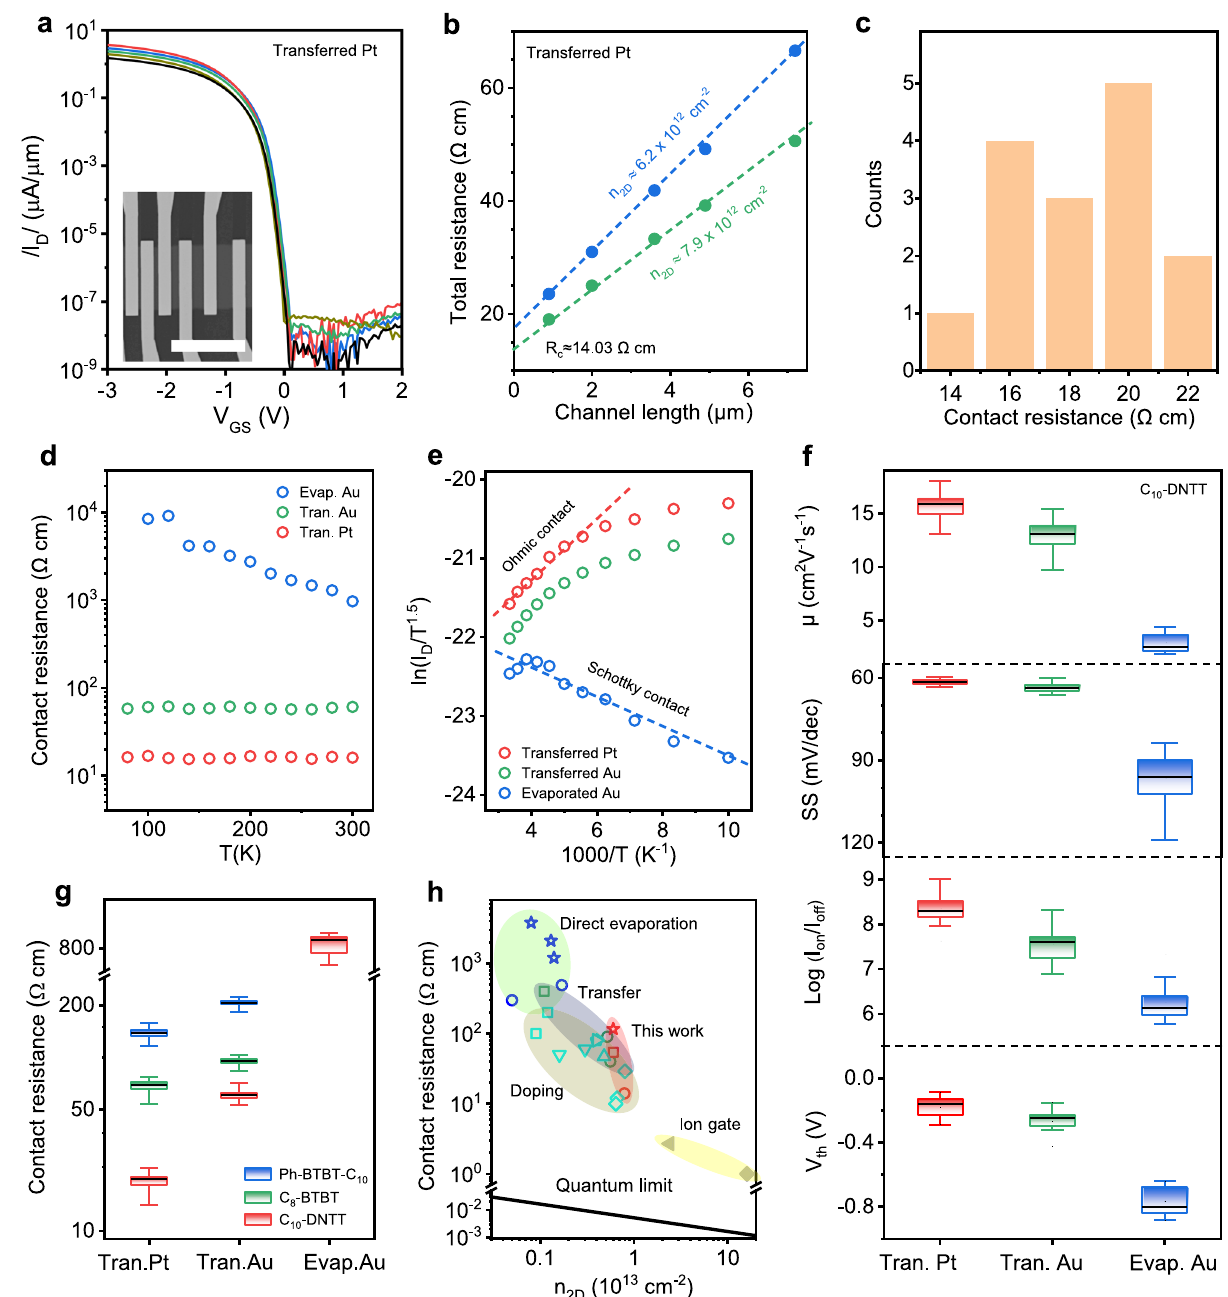
Fig. 2 | Electrical contact properties of transferred-Pt, transferred-Au, and evaporated-Au monolayer C 10 -DNTT OTFTs. a Room temperature I D ~V GS char- acteristics of a typical TLM structure of transferred-Pt OTFTs with a channel length of 0.9, 2.0, 3.6, 4.6, and 7.2 μ m under V DS = − 1.0V. The TLM structure has the same channel width of 27 μ m. Inset shows the scanning electron microscope (SEM) image of TLM structure. Scale bar, 30 μ m. b R c extraction using TLM methodfromthedevicein a . c Histogramofthecontactresistanceoftransferred- Pt OTFTs. d The R c as a function of temperature in three types of OFETs. The contact resistances in c , d were extracted at V DS = − 1.0V and n 2 D =7.9×10 12 cm − 2 . e ArrheniusplotsoftheOhmictransferred-Pt(redopencircle)andtransferred-Au (green open circle) OTFTs at V GS = − 3.0V and V DS = − 0.3 V, and Schottky evapo- rated OFETs (blue open circle) at V GS = − 3.0V and V DS = − 1.0V, respectively. The channellengthandwidthseeSupplementary Figs. 5and7. f Statistics ofeffective mobility( μ ),subthreshold swing(SS), on/off ratio ( I on / I off ), andthreshold voltage ( V th ) of 42 transferred-Pt, 16 transferred-Au, and 21 evaporated-Au contact C 10 -